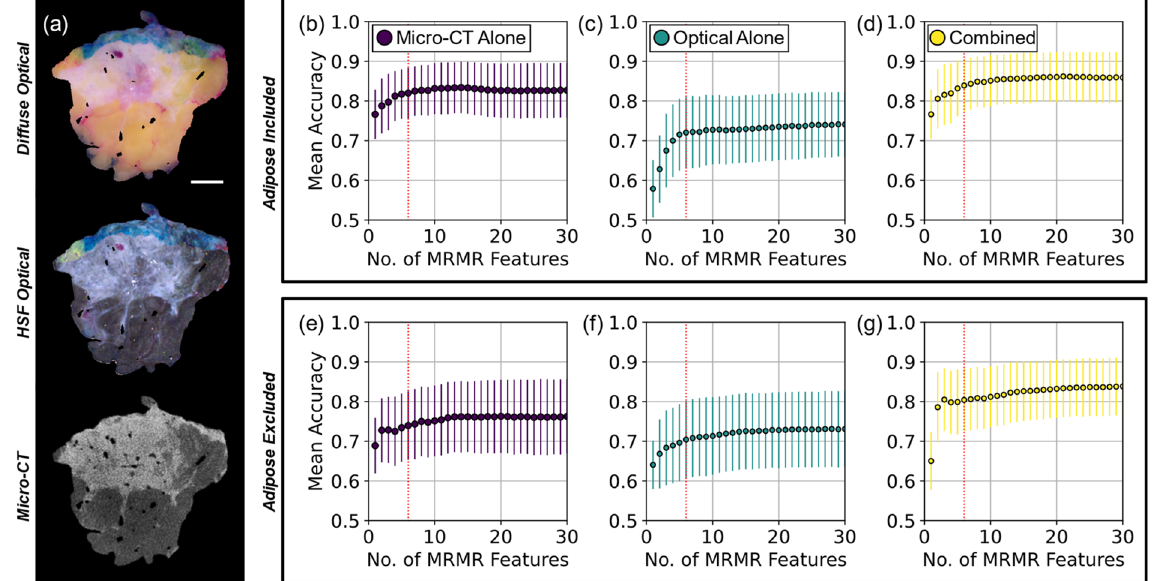
Figure 1. Mean classification accuracy derived from 5 × 5 mm sub-image samples as a function of the number of optimal MRMR features used in n = 1000 Monte Caro cross-validation splits. ( a ) Diffuse optical reflectance, high spatial frequency (HSF, 1.37 mm −1 ) optical reflectance, and a micro-CT slice of a representative tissue specimen with 1-cm scalebar. Mean accuracies when adipose tissue was included (top row, b – d ) and excluded (bottom row, e – g ). Dashed red vertical lines mark six features, the threshold at which the percent change in mean accuracy dropped below 1% for combined classification in ( d ) and ( g ). Error bars represent ± one standard